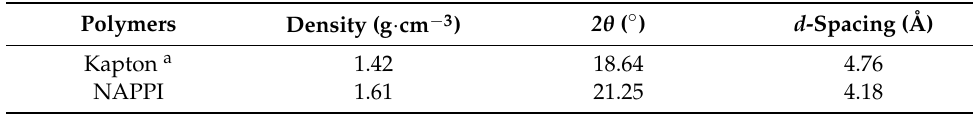
Table 3. Physical properties of the NAPPI and Kapton.